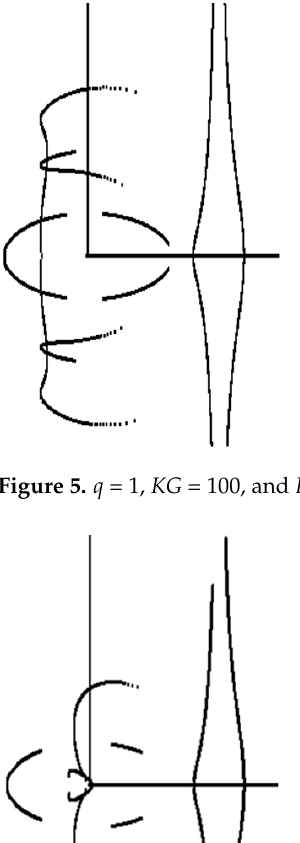
Figure 4. q = 1, KG = 60, and DK = 130.